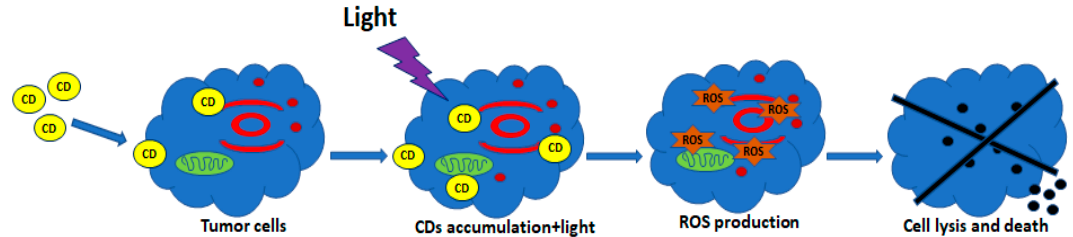
Figure 3. Schematic diagram of photodynamic therapy (PDT). CDs penetrate the cell membrane and accumulate in the cytosol. Light irradiation activates CDs and induces the production of reactive oxygen species (ROS) leading to the cell lysis and death.